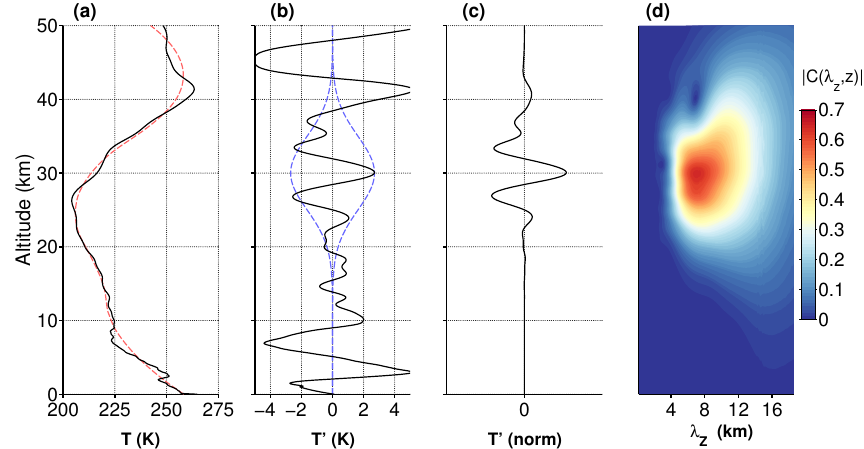
Figure 5. Wave identification (Wave-ID) methodology for an example COSMIC profile at 23:19UTC on 01 August 2010 at 53 ◦ S, 50 ◦ W. Panels show (a) raw temperature profile T (black solid) and filtered background temperature profile ¯ T (red dashed), (b) temperature pertur- bation profile T (cid:48) (black solid) and a Gaussian window centred on 30km (blue dashed), (c) windowed, RSS-normalised and zero-averaged perturbation profile T (cid:48) norm and (d) magnitudes of the spectral coefficients of the continuous wavelet transform of T (cid:48) norm . For details, see